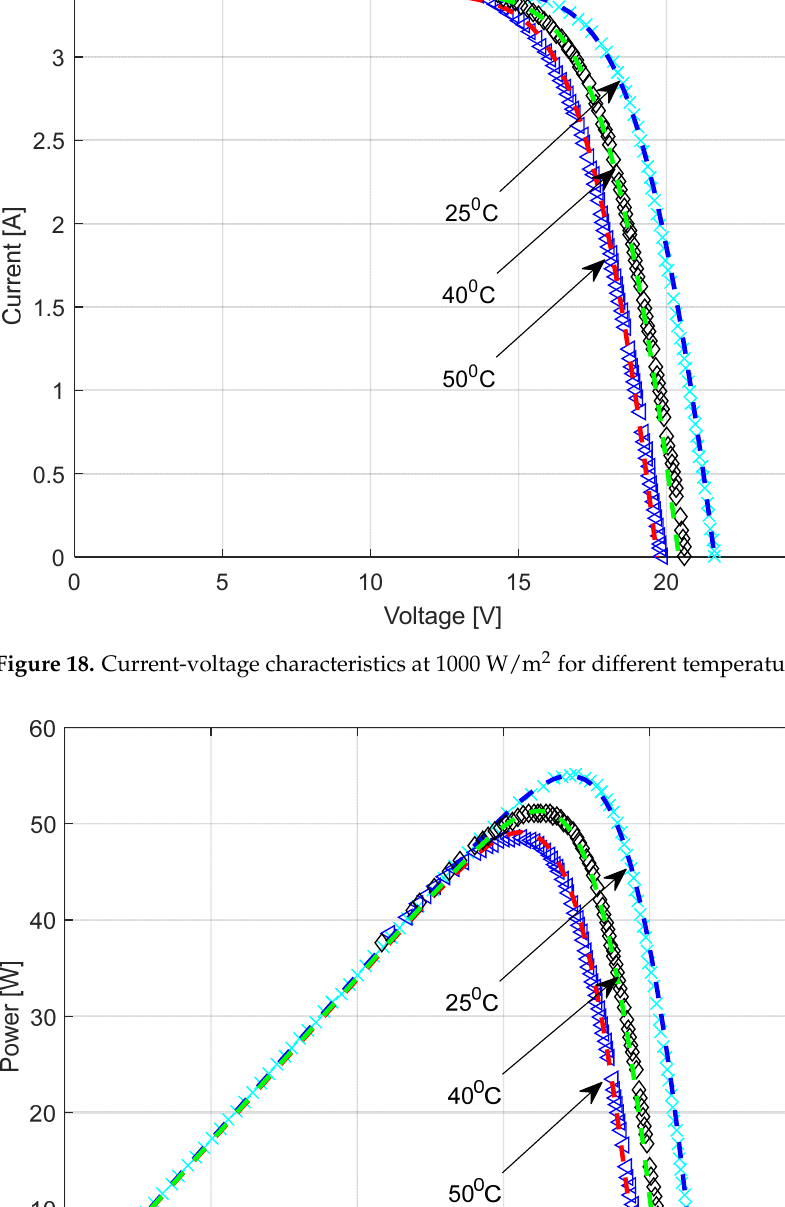
Figure 17. Power-voltage characteristics at 25 °C for different irradiance levels.